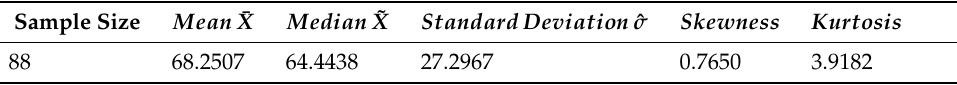
Table 16. Theoretical statistical measures of SBXLL from data-III.